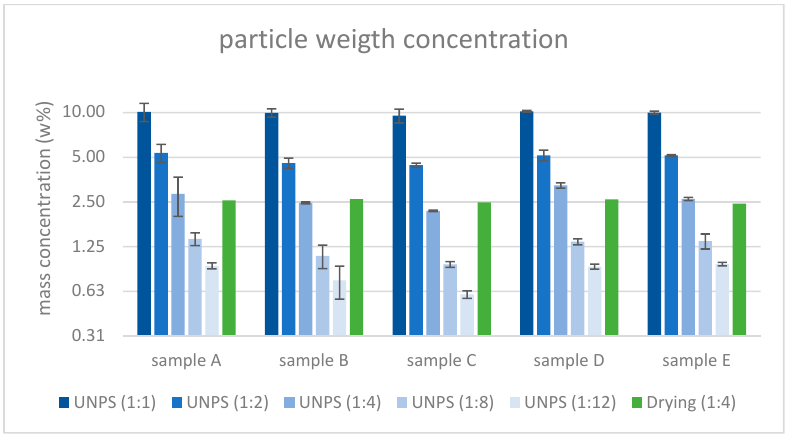
Figure 4. UNPS and transmission electron microscope (TEM) measurements of the mean particle diameter of the silica samples.